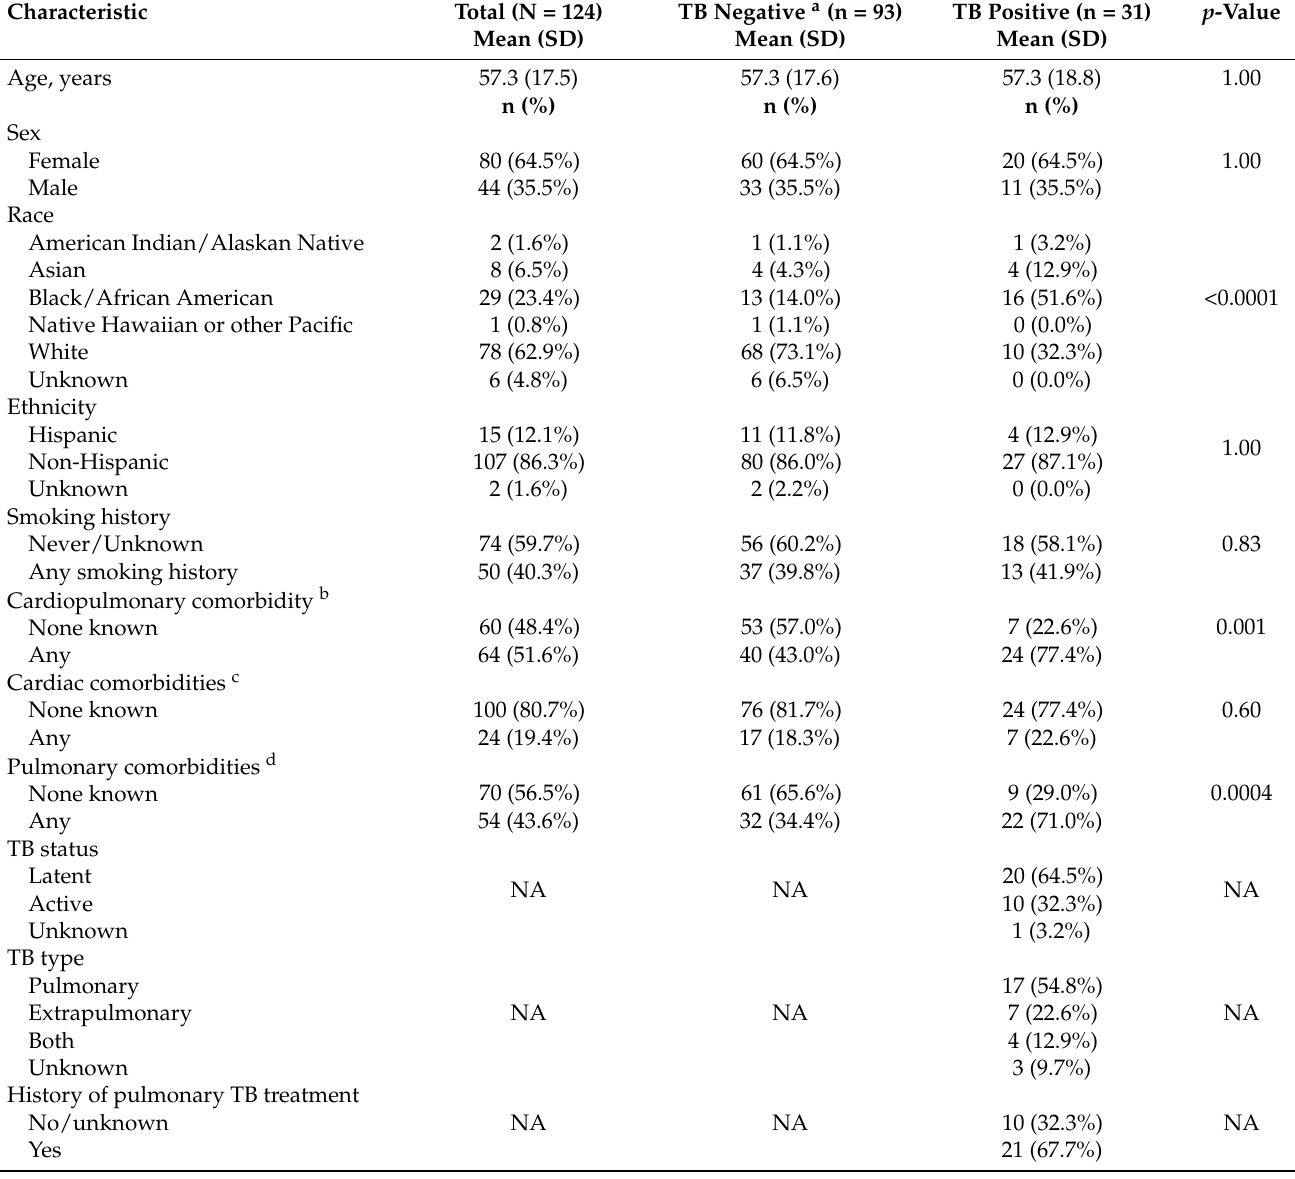
Table 1. Distribution of demographic and clinical characteristics among patients with coronavirus disease 2019 (COVID-19), by tuberculosis (TB)